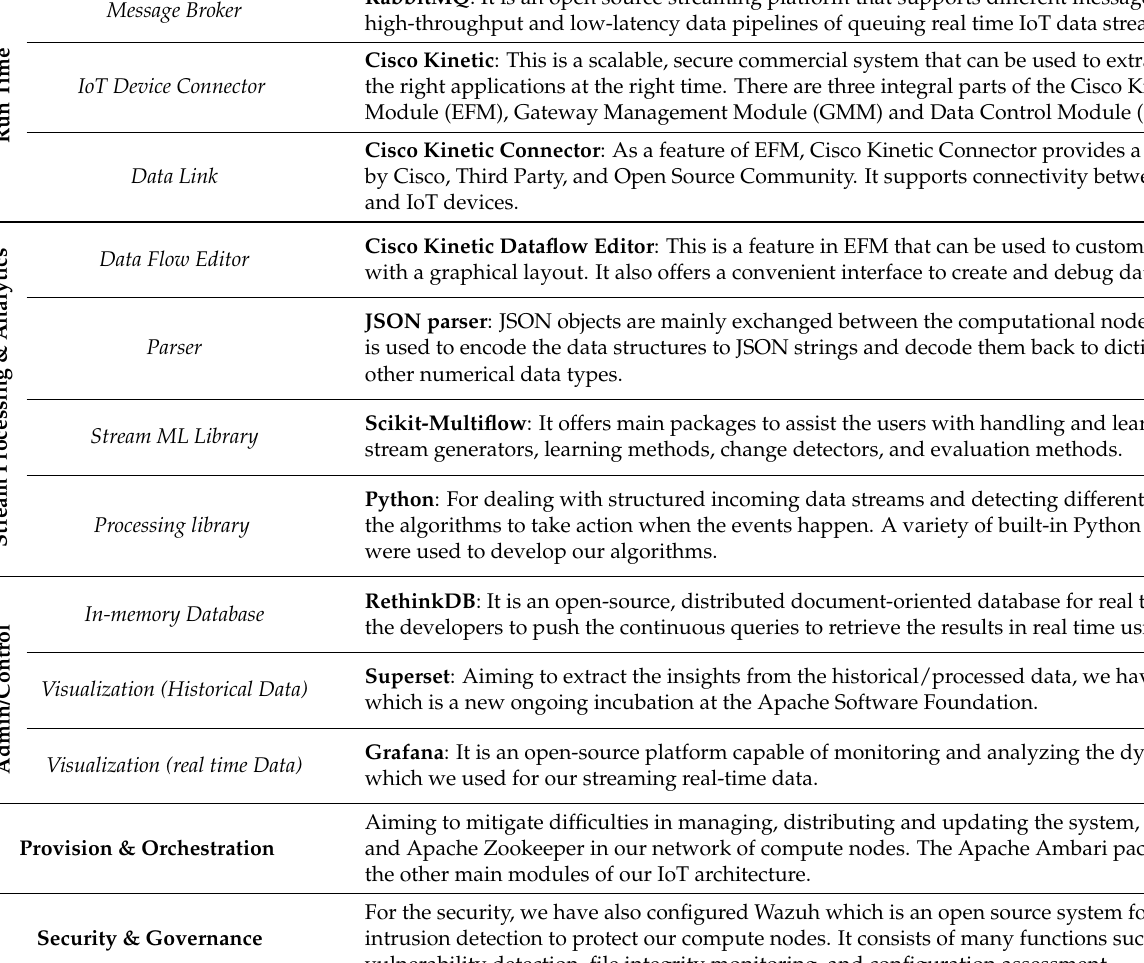
Table 2. Software used for the modules